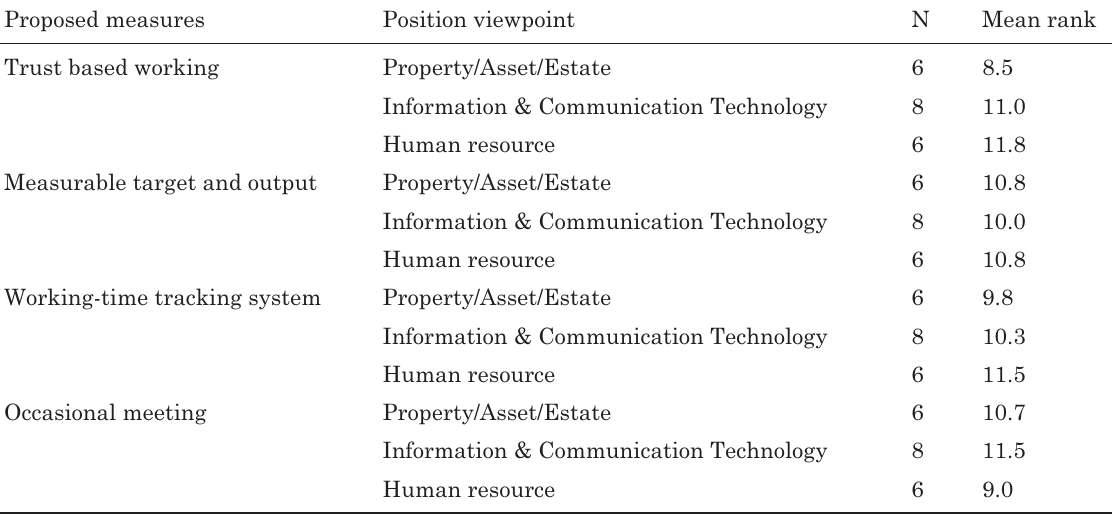
Table 9. Mean rank for Kruskal Wallis Test of monitoring fl exible working staff Proposed